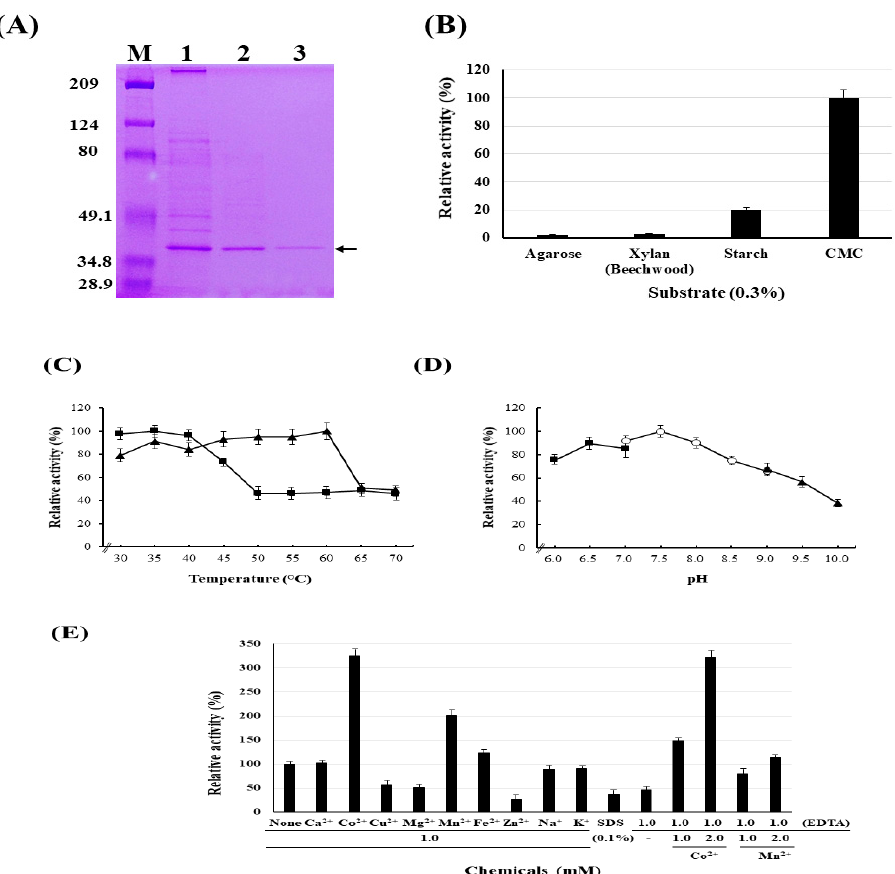
Figure 4. Purification and biochemical characterization of an extracellular cellulase, CelA J93, from the culture broth of Cellulophaga sp. J9-3. ( A ) Sodium dodecyl sulfate-polyacrylamide gel electrophoresis of protein samples during purification. Lane M, protein molecular weight markers; 1, 75%